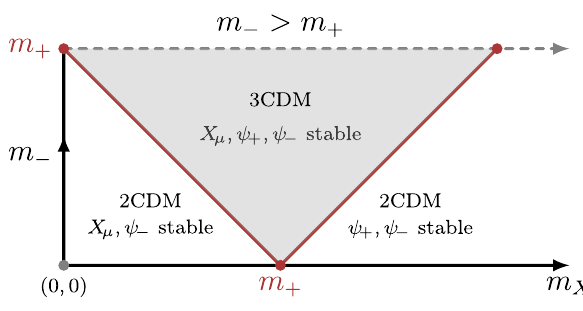
Fig. 1 The most relevant Feynman rules for vector-fermion dark mat- ter sector ( X is the dark vector and ψ ± are the dark fermions) and its mixing with the SM, where V represents the SM gauge bosons ( Z , W ),